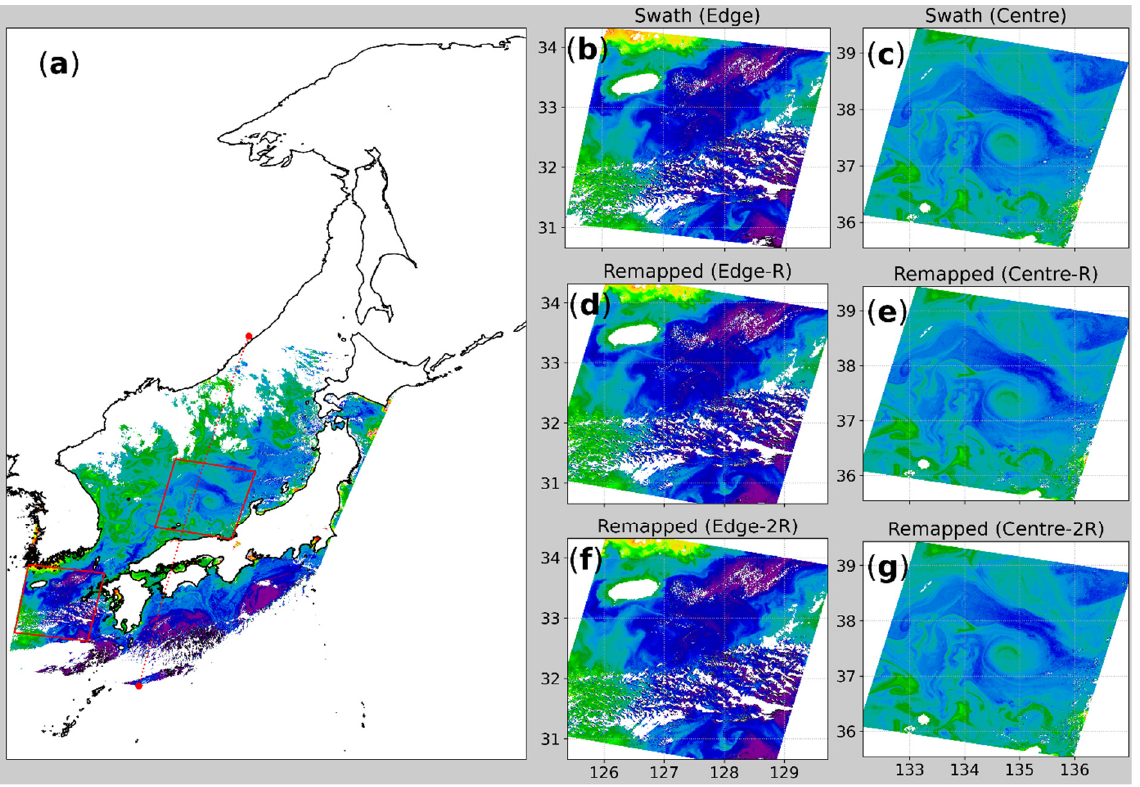
Figure A6. Same as in Figure 2 but for SGLI/GCOM-C. Sample data used is indicated in Table 1. At the center box, a patch of isolated high chlorophyll can be seen swirling clockwise. The area is known to be an eddy rich with significant impacts on phytoplankton bloom timing [35,36].